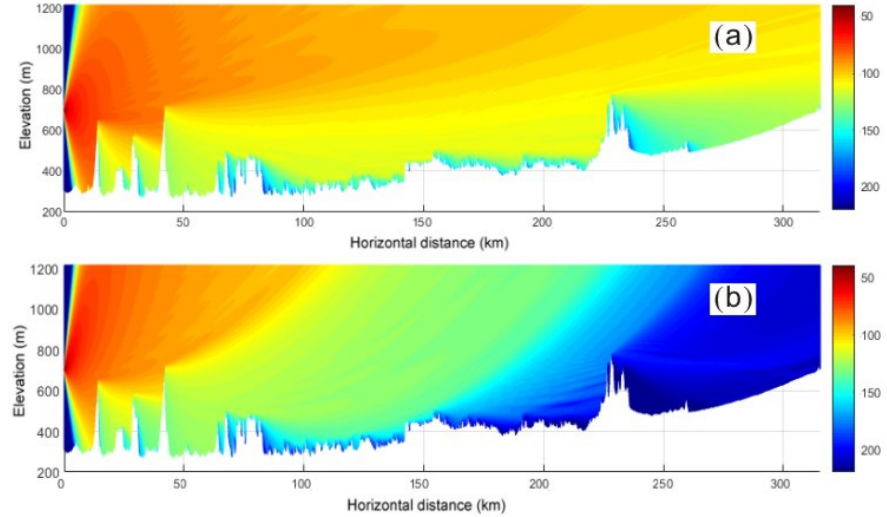
Figure 7. Electric field distribution calculated by PE model: ( a ) Without refraction. ( b ) With modified refractivity.